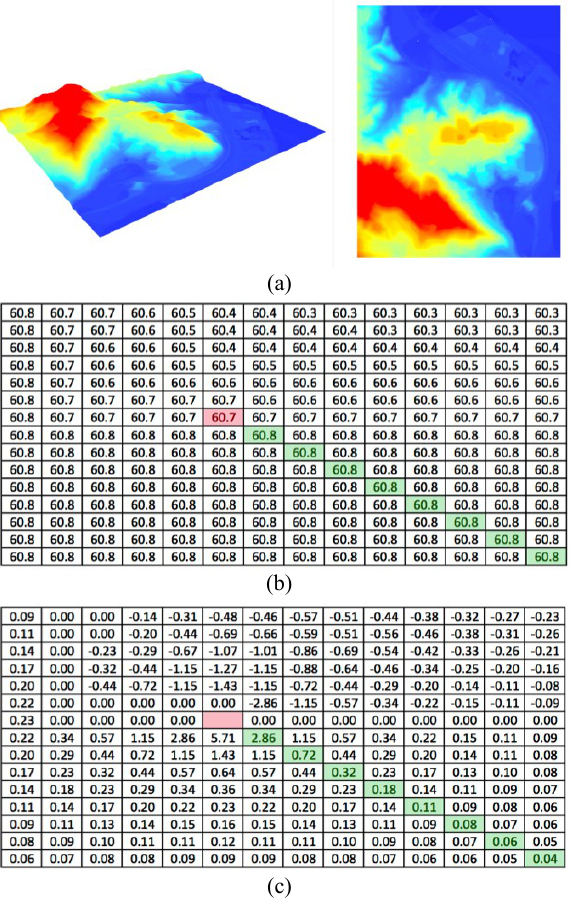
Figure 6. (a) DEM Used in this Experiment (CUHK Campus, 0.5m * 0.5m); (b) DEM (Height Matrix): Use the algorithm to calculate the visual data for each pixel, and do the comparison; (c) Visual Angle for DEM: For direction 135, take max value of 2.86 as the visual angle for Point Red (E.g.)